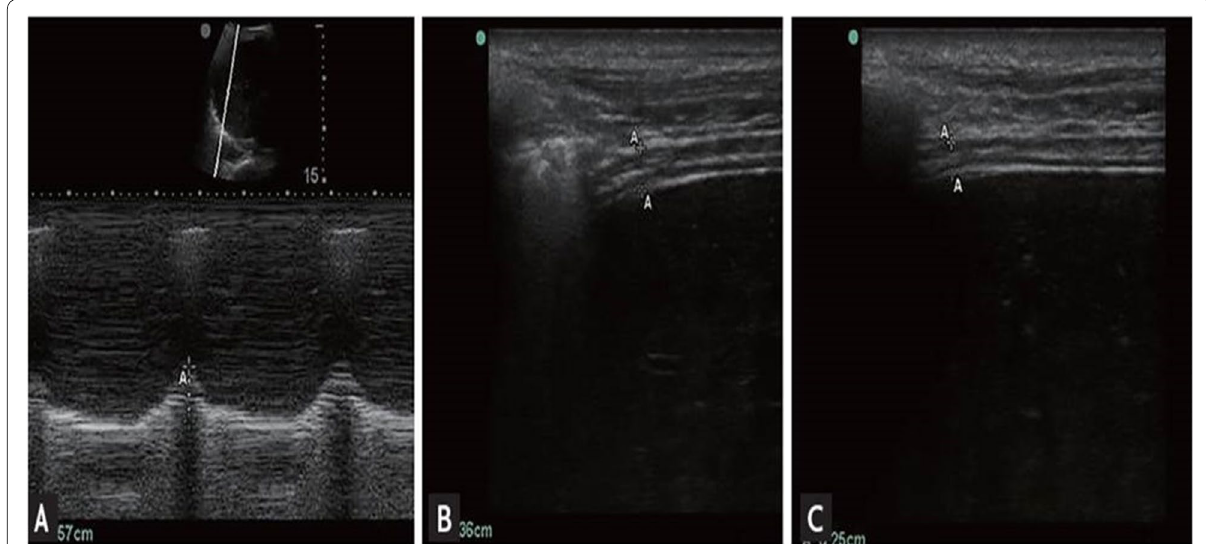
Fig. 1 M-mode of diaphragm excursion ( A ) and B-mode of diaphragm thickness ( B , inspiration; C ,